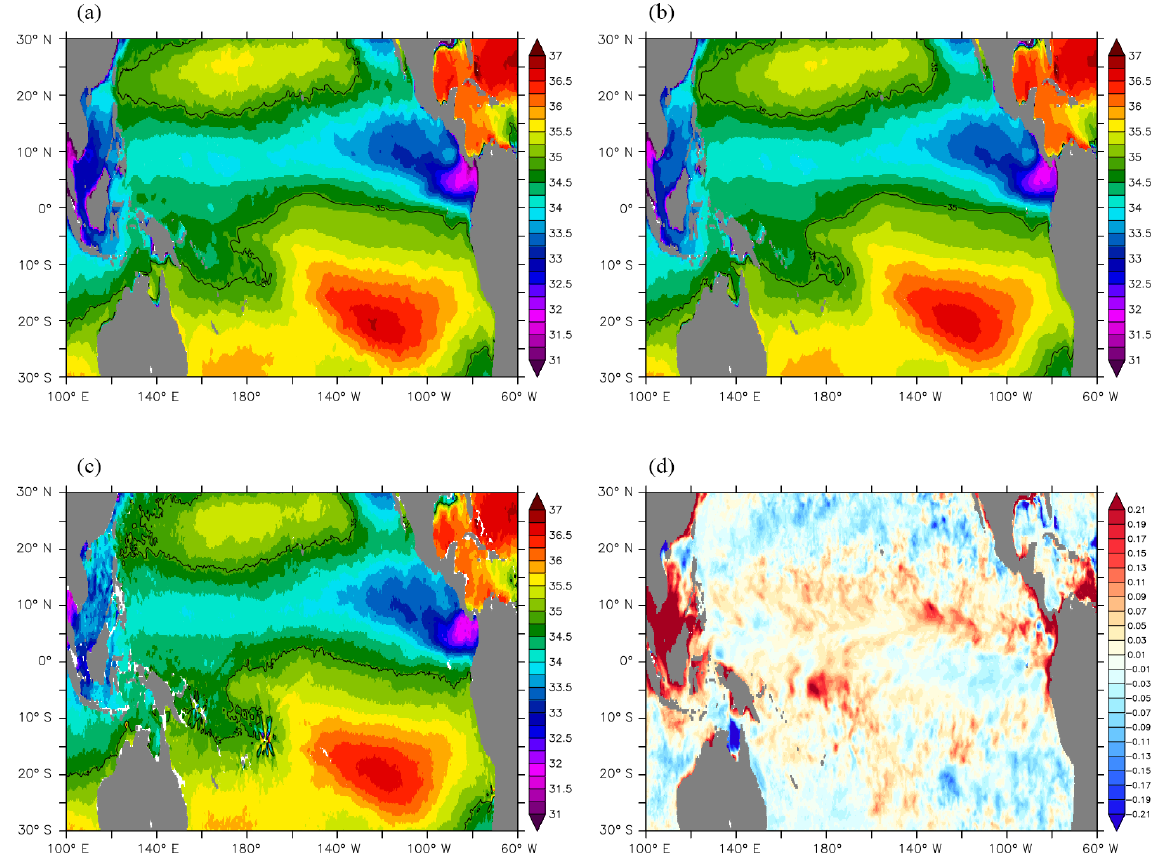
Figure 9. Mean October 2015 SSS estimation from the REF experiment (a) , the SMOSexp experiment (b) , the SMOS SSS measurements (c) and annual mean difference (2015) between the SMOSexp and REF experiment (d) . The isohaline 34.8pss is the (black solid line) is represented.